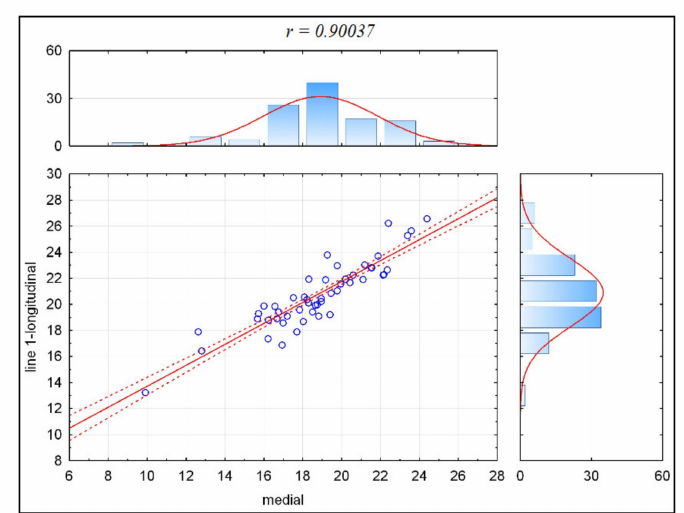
Figure 4. Correlation between the pairs of parameters (medial and line-1 longitudinal) in whole